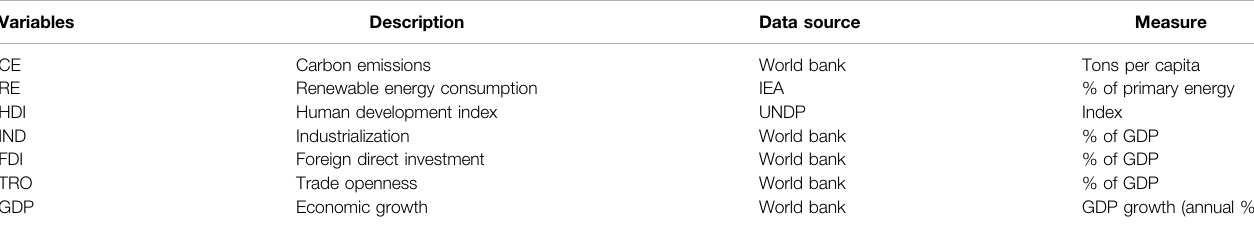
TABLE 1 | Variable description.